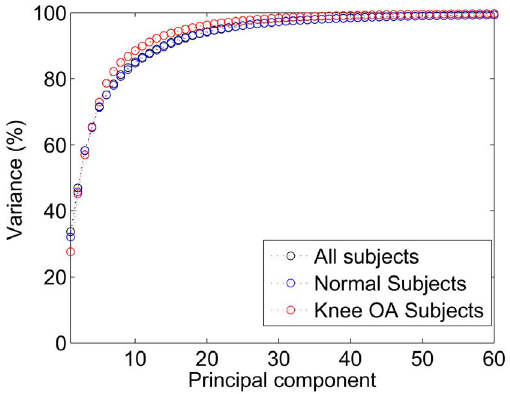
Figure 6. How much variability is explained as a function of the number of the components. The x-axis corresponds to the number of PCs, whereas the y-axis the percentage of the variance of the GRF patterns explained by the respective number of PCs. It is evident that human walking is a complex process, since the slope starts at a low point (1 PC explains just above 30% of the variability of the combined data) and the slope progresses slowly.